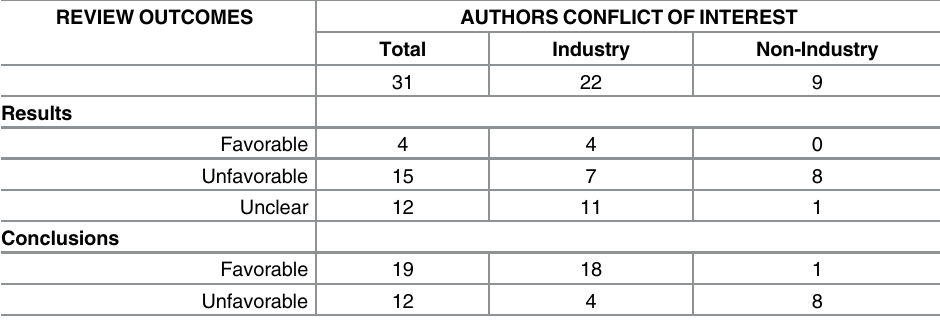
Table 3. Results and conclusions of reviews by conflicts of interest of authors (n =